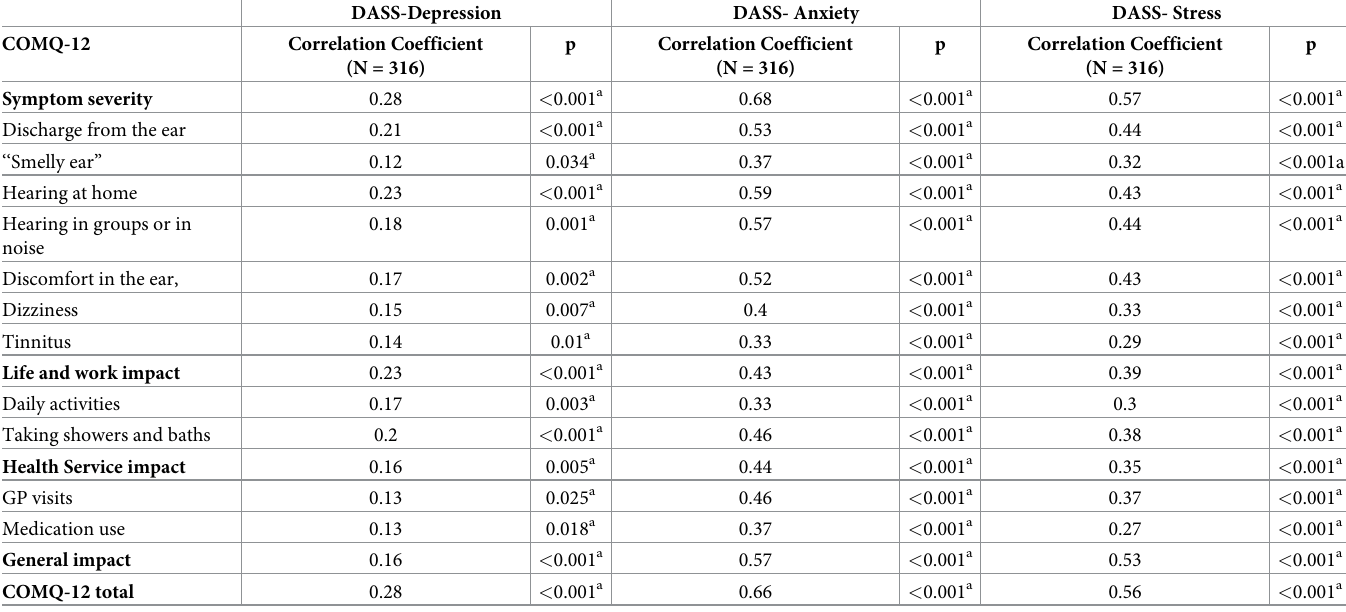
Table 3. Correlation between DASS subscale scores and COMQ-12